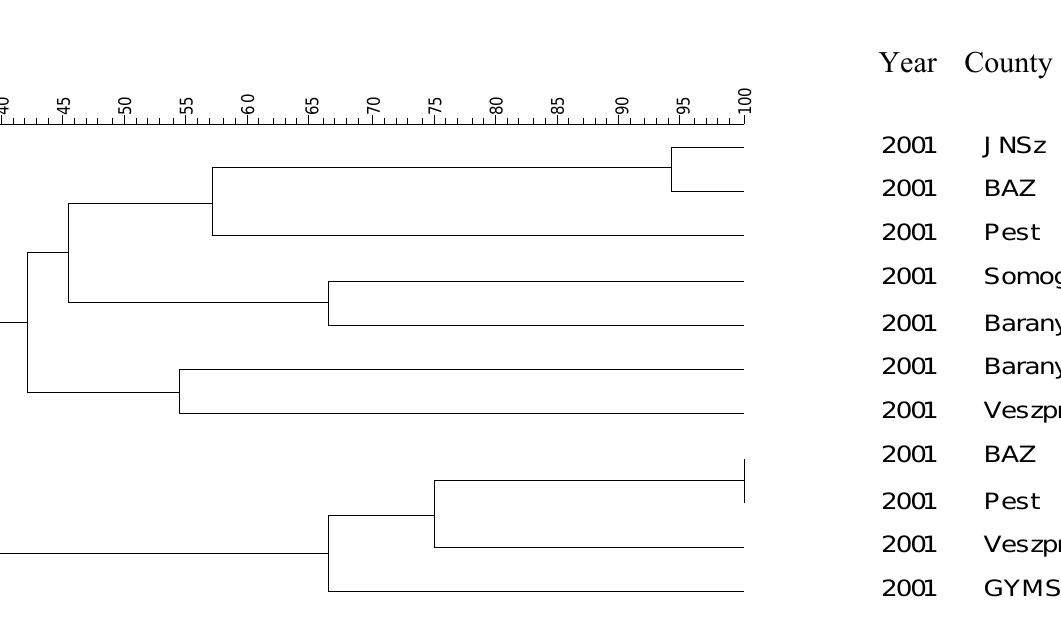
Dice (Opt:1.00%) (Tol 2.0%-2.0%) (H>0.0% S>0.0%) [0.0%-100.0%]